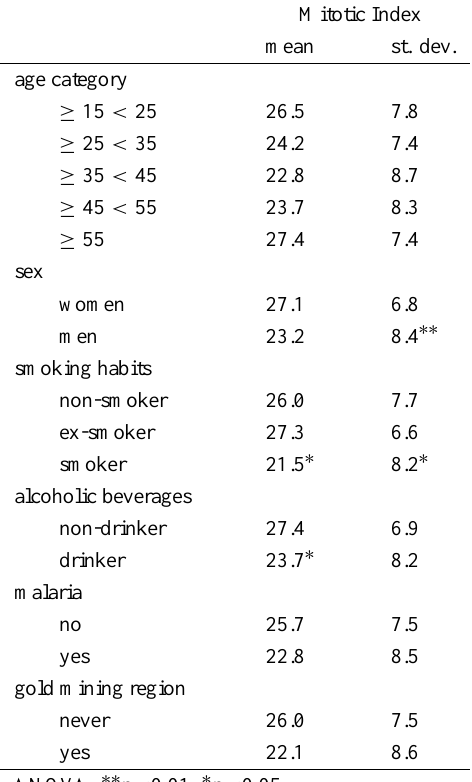
Mean mitotic index per 1000 cells with respect to the characteristics of the study